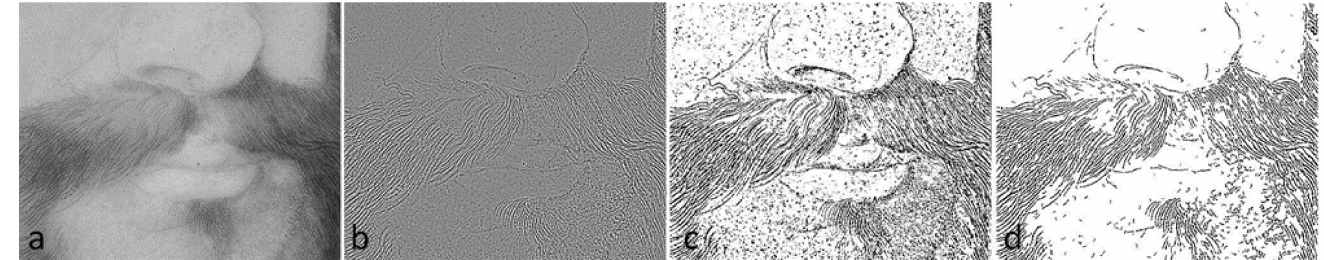
Figure 5. Pipeline of the elaboration for the underdrawing extraction: ( a ) SWIR image, ( b ) local contrast enhancement, ( c ) binary mask with ad-hoc parameters, ( d ) binary images filtered on the basis of spatial features (dimension and circularity of pixels), where the underdrawing is highlighted.